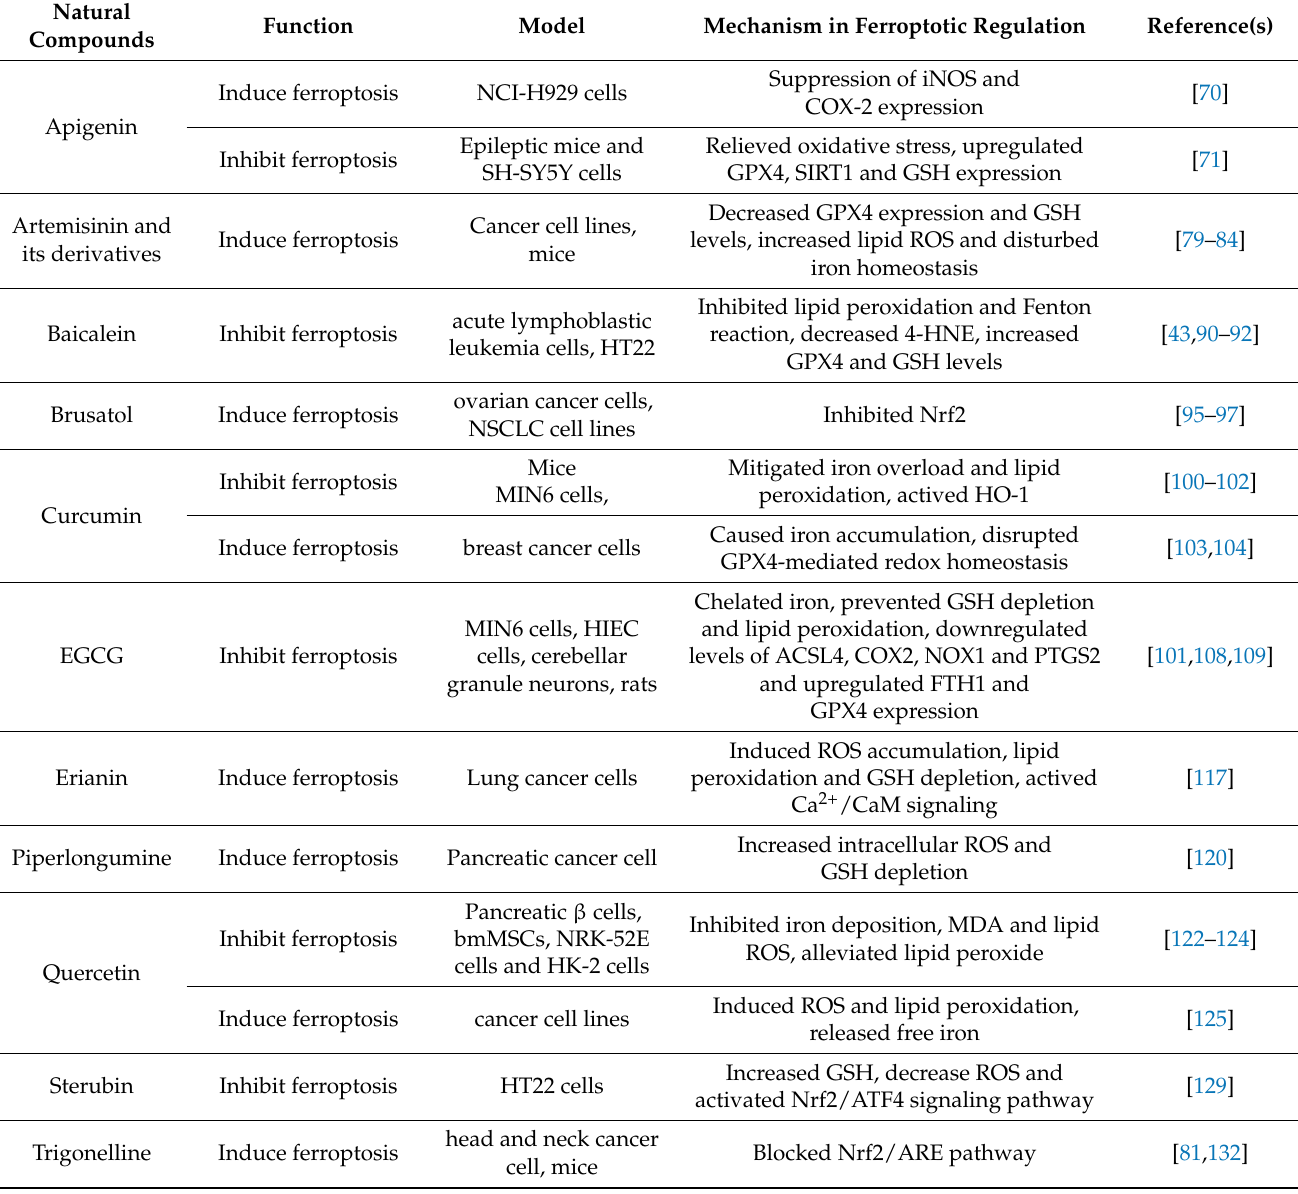
Table 1. Representative natural bioactive compounds as ferroptosis